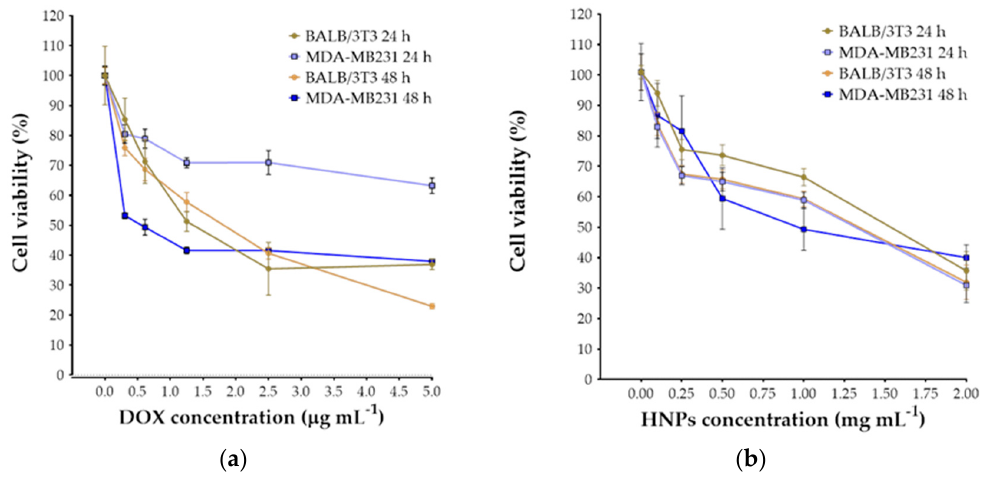
Figure 6. Determination of IC 50 of free DOX ( a ) and self-assembling nanoparticles (HNPs) ( b ) for metastatic cancer (MDA-MB231) and healthy (BALB/3T3) cells after 24 and 48 h of cell culture. The effects of DOX@HNPs on the inhibition of cell proliferation were evaluated using MDA-MB231 and BALB/3T3 cell lines (Figure 7). The increase in DOX concentrations led to a gradual decrease in the viability of both cancer and fibroblast cell lines. The cytotoxic effects of DOX@HNPs were significantly higher in MDA-MB231 cells than in fibroblasts when comparing the same DOX concentrations. After 24 h, the incubation of both cell lines with DOX@HNPs loaded with 0.625 μ g mL − 1 led to similar values of cell survival (64.6 ± 10.6% and 61.0 ± 14.6% for BALB and MDA, respectively). However, higher concentrations of DOX (1.25, 2.5, and 5 µ g mL − 1 ) were significantly more cytotoxic for MDA cells compared to BALB. Incubation of MDA cells with DOX@HNPs containing DOX concentrations of 1.25 µ g mL − 1 decreased cell viability to values close to 20% (23.3 ± 5.4%) after 24 h. However, BALB cell viability was not significantly more affected (55.3 ± 9.0%) at this concentration compared to DOX@HNPs 0.625 μ g mL − 1 . The cytotoxicity of DOX-loaded